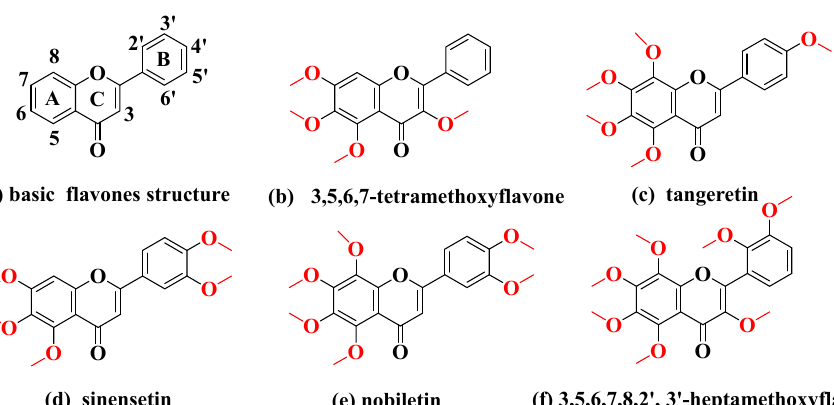
Molecules 2021 , 26 , x FOR PEER REVIEW Figure 1. ( a ) basic structures of the flavones and chemical structures of five polymethoxylated flavones: ( b ) 3,5,6,7-tetramethoxyflavone, ( c ) tangeretin, ( d ) sinensetin, ( e ) nobiletin, ( f ) 3,5,6,7,8,2 ′ ,3 ′ -heptamethoxyflavone.